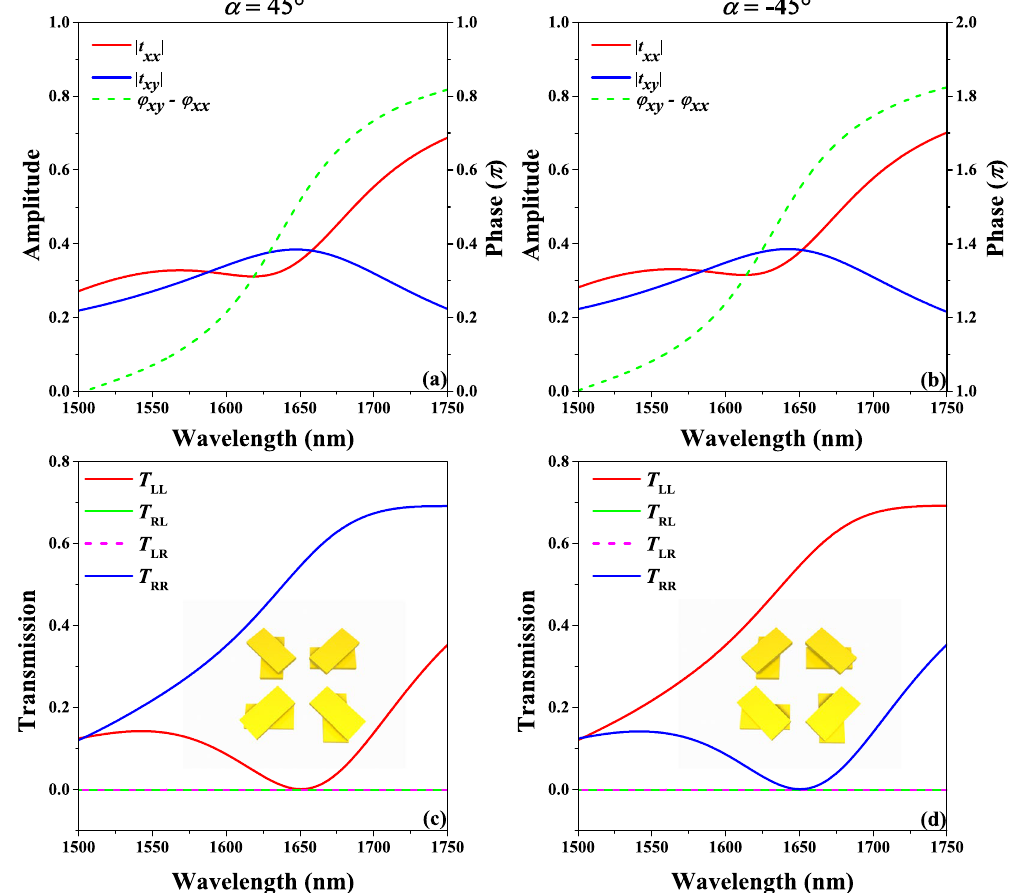
Figure 2. The analysis of T matrix coefficients of the designed metasurface. ( a ) and ( b ) Simulation results of the amplitudes and phase differences of linear base coefficients t xx and t xy of the two-layer metasurface with values of the orientation angle α of 45° and − 45°, respectively. ( c ) and ( d ) Simulation results for the squared moduli T ij = | t ij | 2 of the circular base coefficients of the two-layer metasurface with values of the orientation angle α of 45° and − 45°,